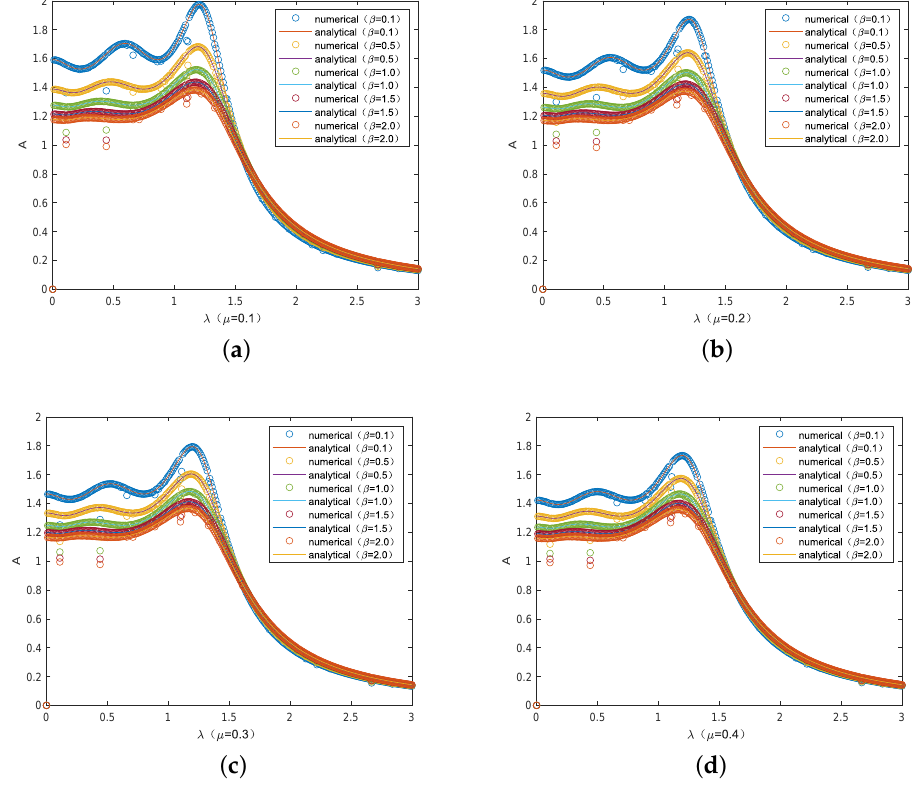
Figure 6. Comparison between the numerical solution and analytical solution in initial optimization ( α 2 opt = α 2 b ): ( a ) µ = 0.1; ( b ) µ = 0.2; ( c ) µ = 0.3; ( d ) µ =